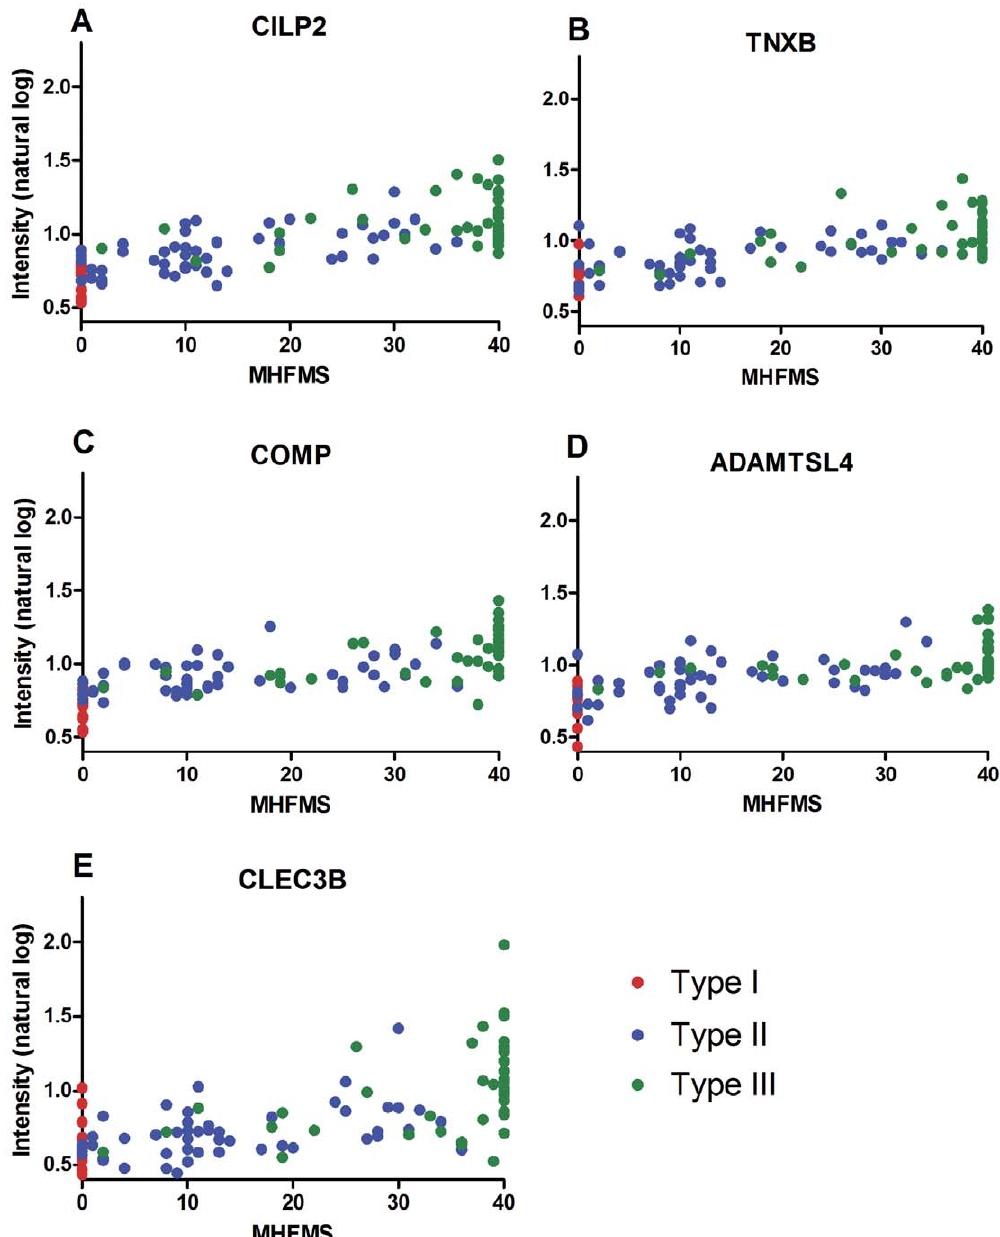
Figure 2. Illustration of the top 5 markers as candidate biomarkers by MFMHS. The natural log intensity of the protein abundance of CILP2, TNXB, COMP, ADAMTSL4 and CLEC3B are shown by MHFMS (Panels A-E) across Types. Panels A-E again show a trend for type and MHFMS. Panels F-J shows the box plot distribution by type.